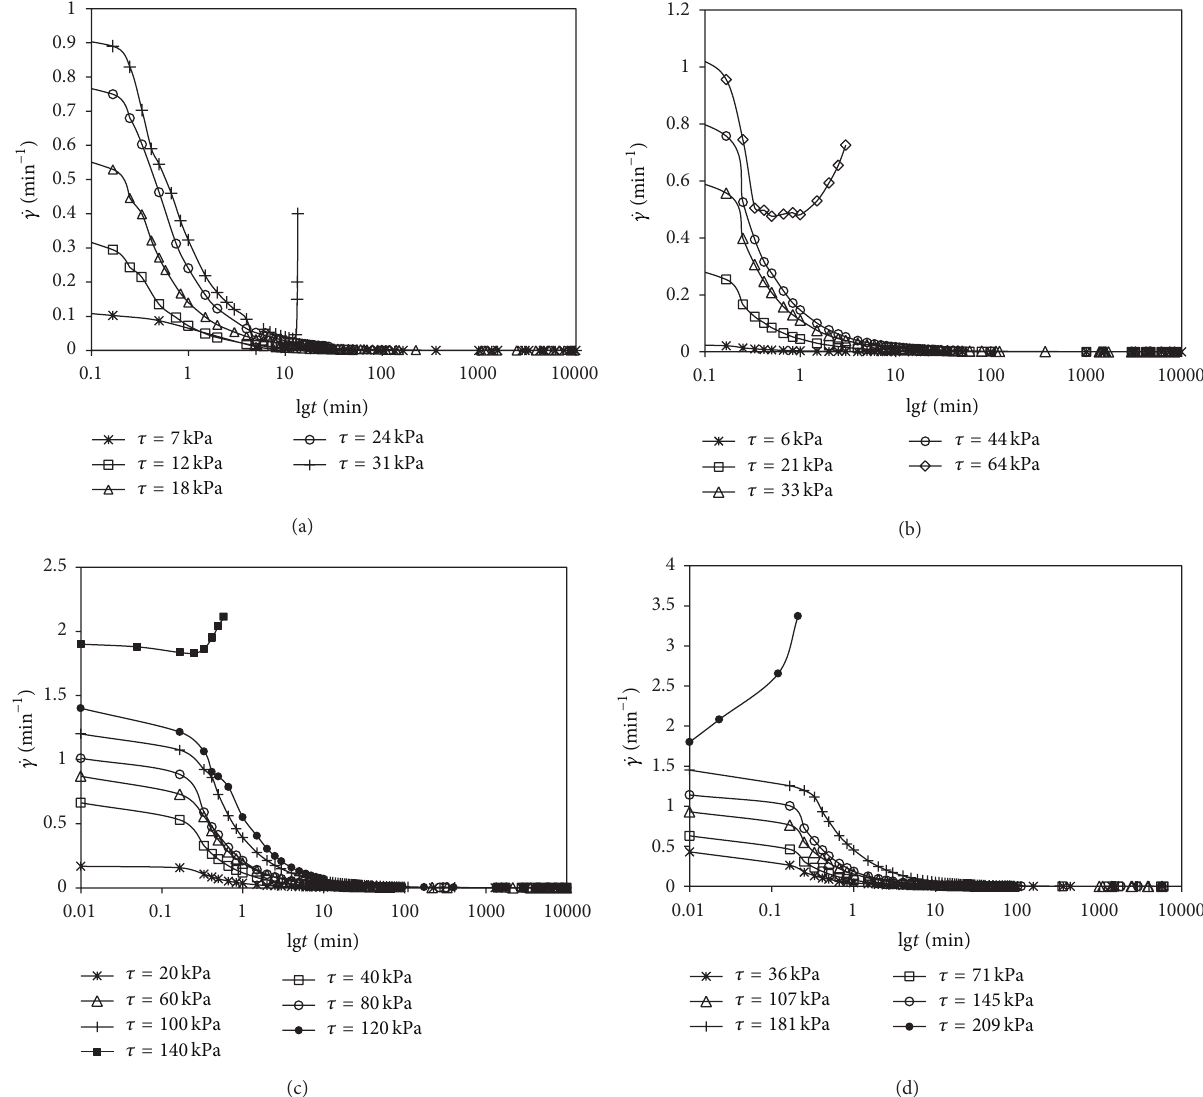
Figure 6: (a) ̇𝛾∼ lg 𝑡 curves for 𝑝 = 50 kPa. (b) ̇𝛾∼ lg 𝑡 curves for 𝑝 = 100 kPa. (c) ̇𝛾∼ lg 𝑡 curves for 𝑝 = 200 kPa. (d) ̇𝛾∼ lg 𝑡 curves for 𝑝 = 300 kPa.